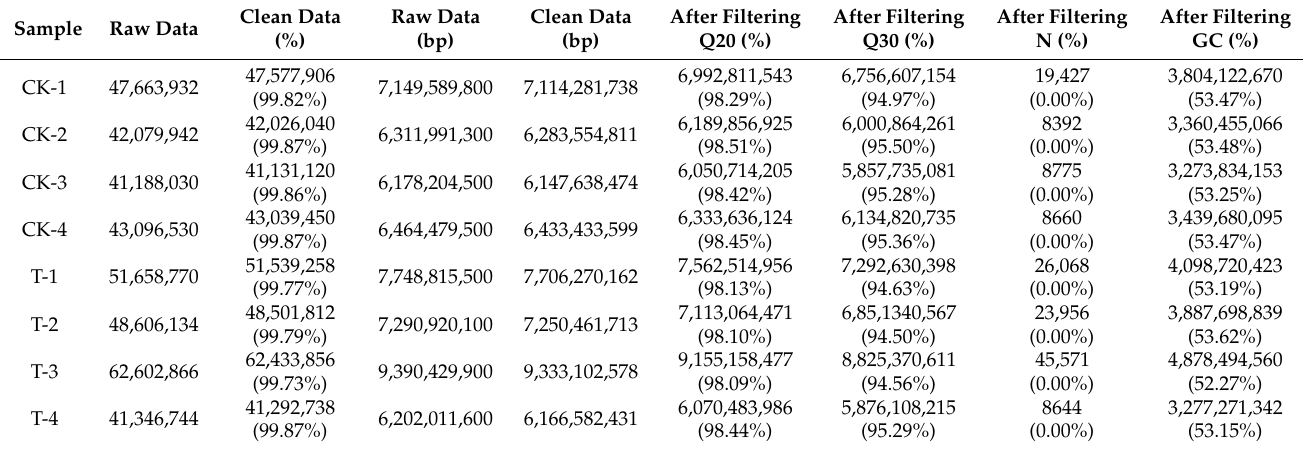
Table 1. Summary of sequence data generated for HepaRG cells transcriptome and quality filtering. Sample Raw